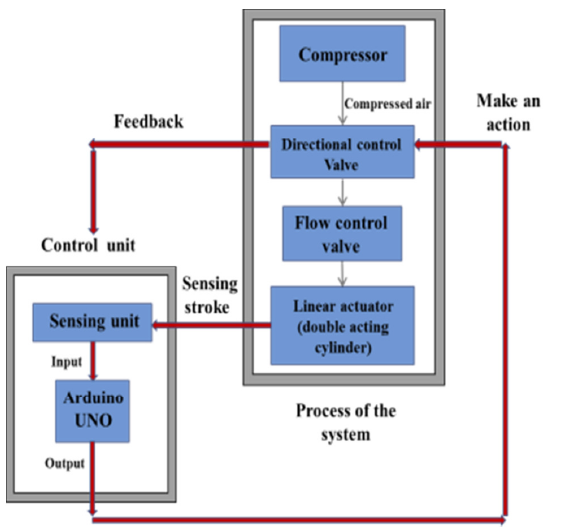
Fig. 2. The mechanism of work of the proposed system.